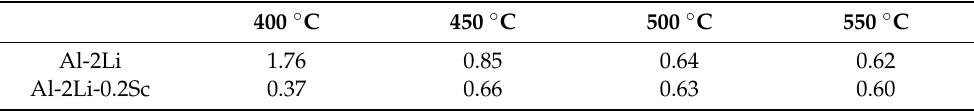
Figure 5. The curve fitting of oxidation weight gain after oxidation of alloy ( a ) Al − 2Li, ( b ) Al − 2Li − 0.2Sc. Table 2. The oxidation reactivity indexes of Al–2Li and Al–2Li–0.2Sc alloys at different exposure temperatures.